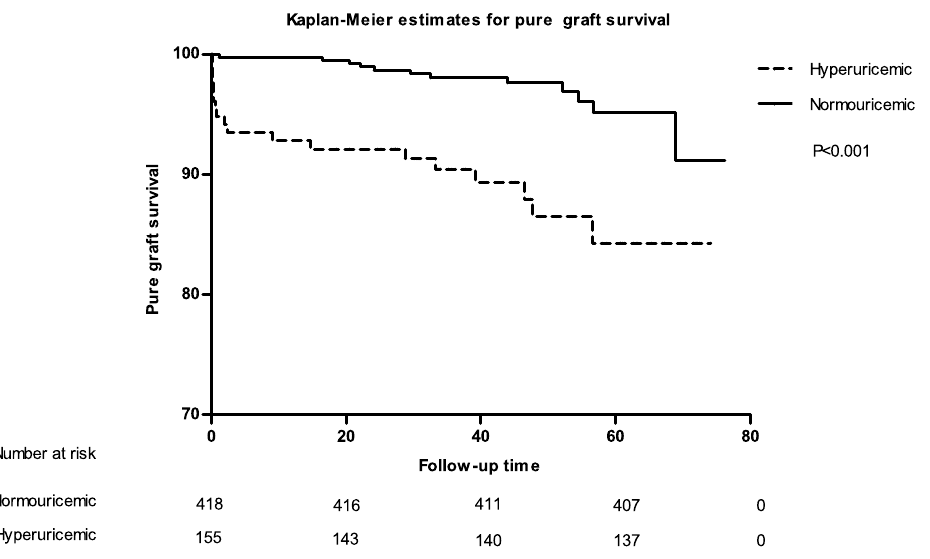
Fig 5. Kaplan-Meier survival curve estimates for pure graft survival. Excluding the dead with functioning kidney, we could observe greater variance between the two groups.